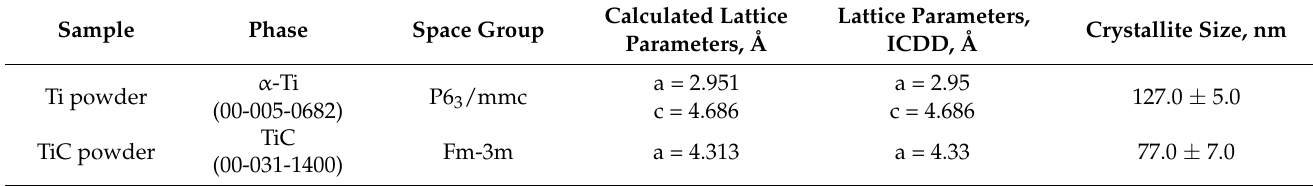
Figure 2. Phase composition of initial powder: ( a ) Ti powder; ( b ) TiC powder, XRD. Table 1. Lattice parameters and crystalline size of initial powder calculated using Rietveld